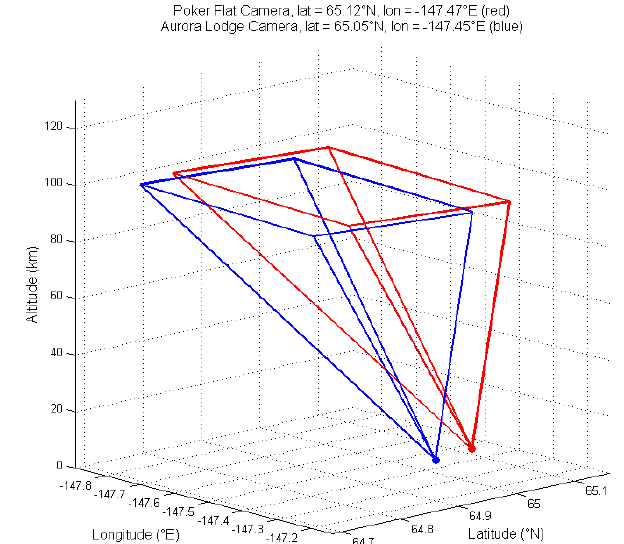
Figure 1. Stereoscopic observation geometry and overlapped fields of view at 100km altitude.